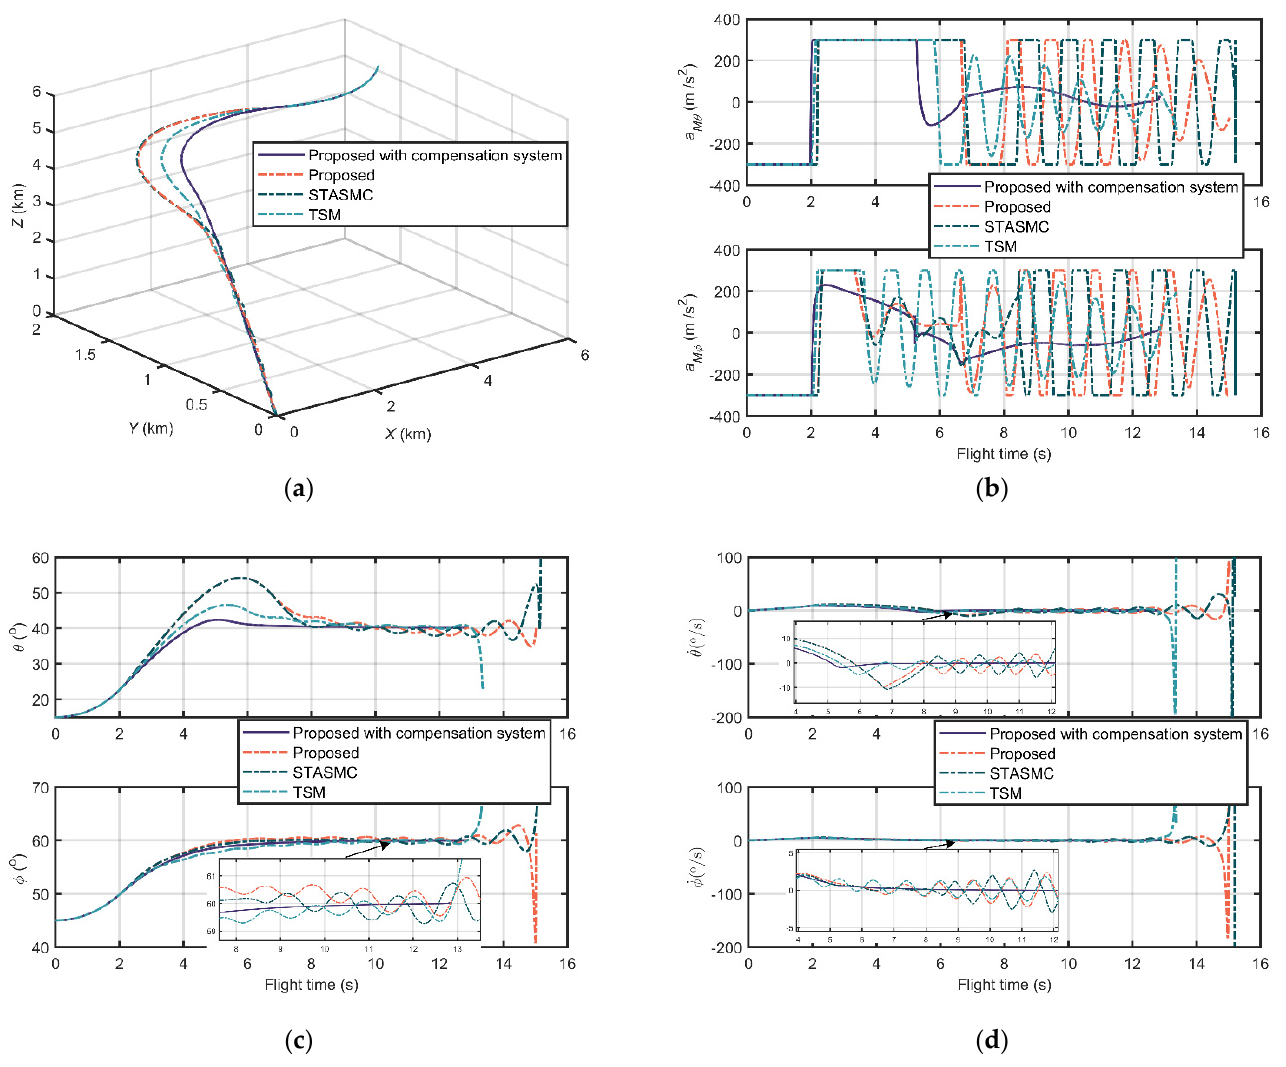
Figure 10. Comparison results of scenario 3: ( a ) Relative distance trajectories; ( b ) Output accelerations of guidance loops; ( c ) LOS angles; and ( d ) LOS angular rates.